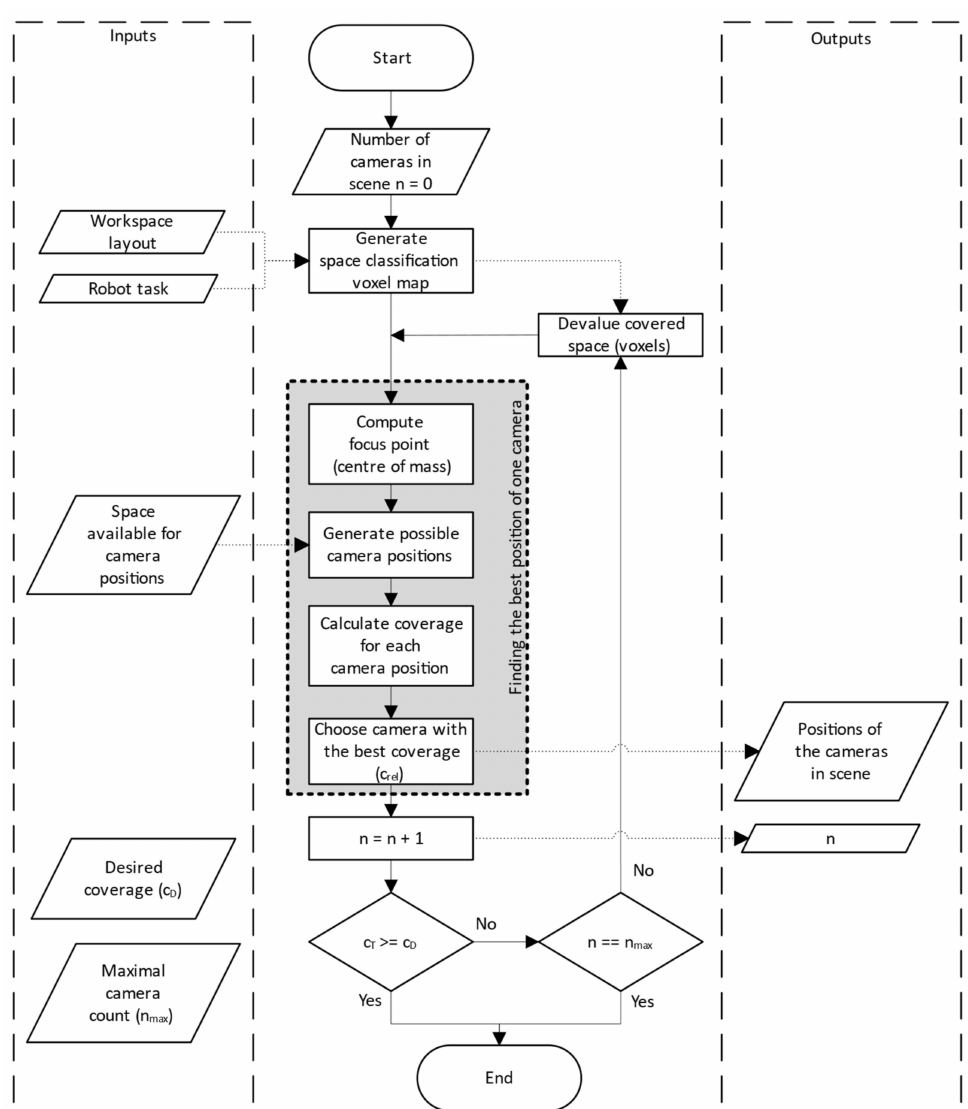
Figure 9. Flowchart describing the whole